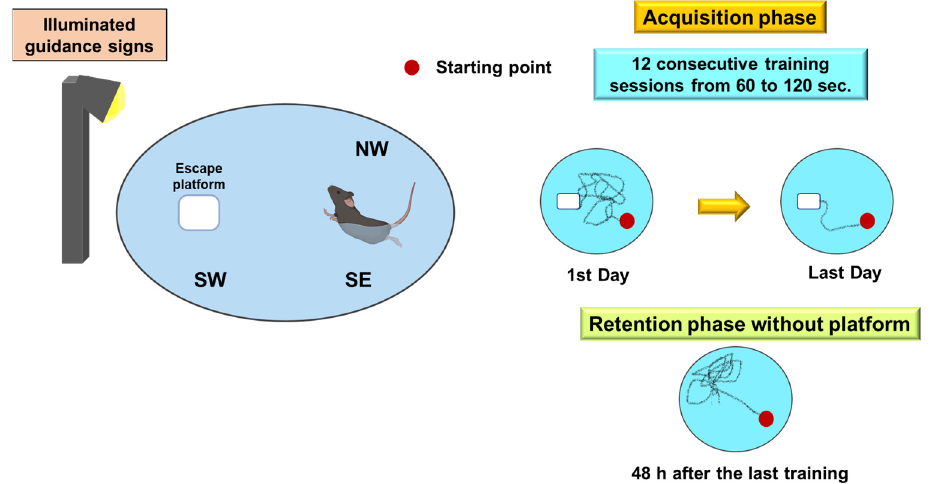
Figure 7. Morris water maze. This test evaluates the latency time that the animal takes to reach the submerged platform, which represents a reinforcing escape stimulus. If the platform remains in the same place, the spatial reference memory is evaluated, and if it varies, the spatial working memory is analyzed.